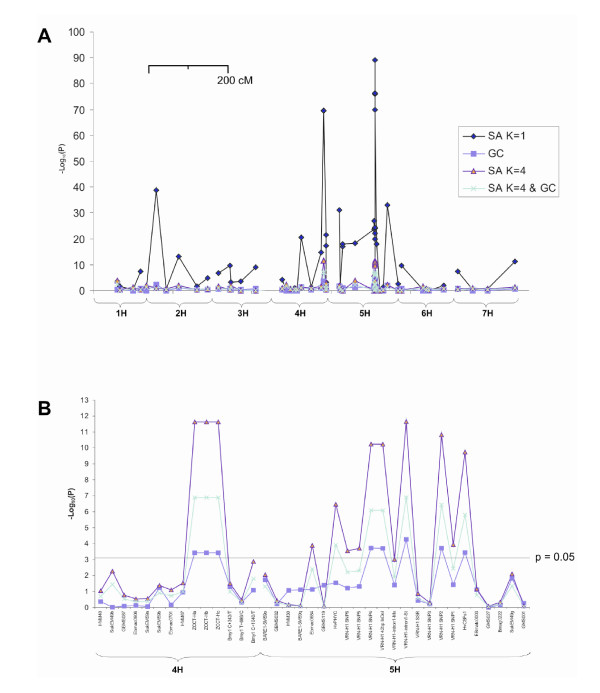
Association mapping of GH in barley. Association of GH with mapped genetic markers using association (SA K = 1), Genomic Control (GC), SA with a population sub-structure = 4 (SA K = 4) and SA with population sub-structure = 4 plus Genomic Control (SA K = 4 & GC). GC was performed using the robust mean of LRT for the unmapped S-SAP markers. (A) All mapped markers. Distance between markers is proportional to scale (cM). (B) Detailed view of mapped markers on chromosomes 4H and 5H (SA K = 1 not shown). Associations between marker and GH are considered significant above p = 0.05/marker number (Bonferroni correction). Distance between markers is not to scale.